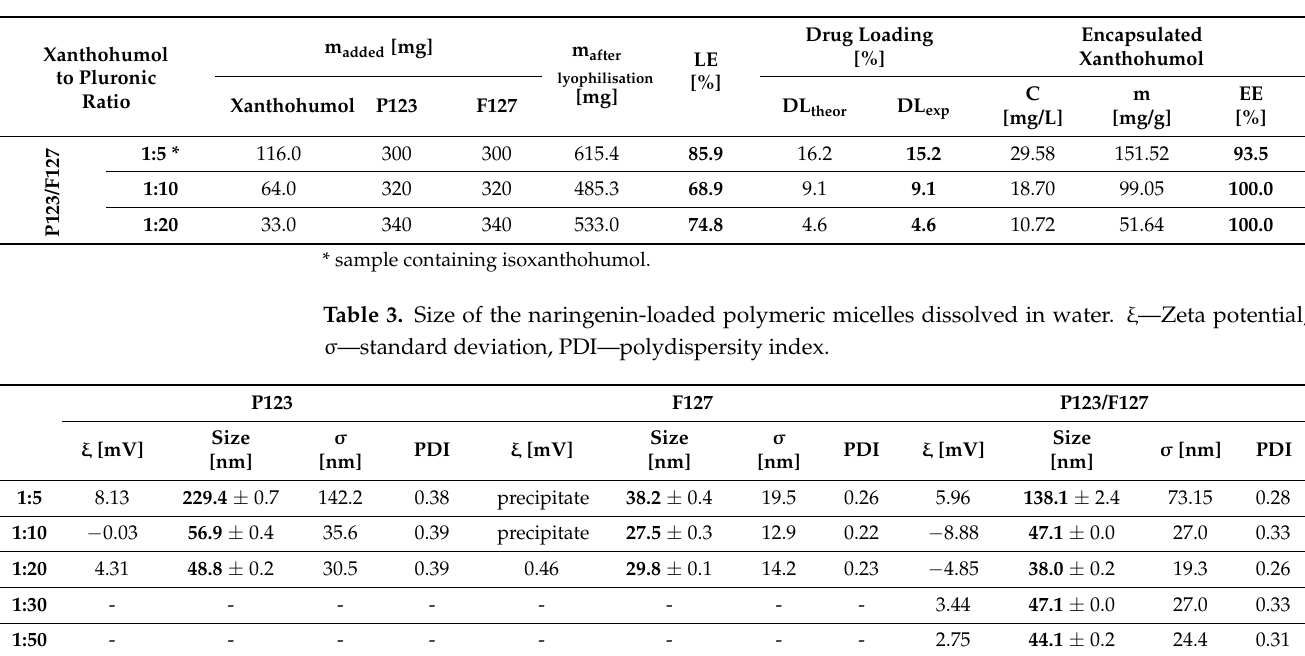
Table 2. Results of xanthohumol-loaded micellar nanoparticles preparation. LE—lyophilisation efficiency,